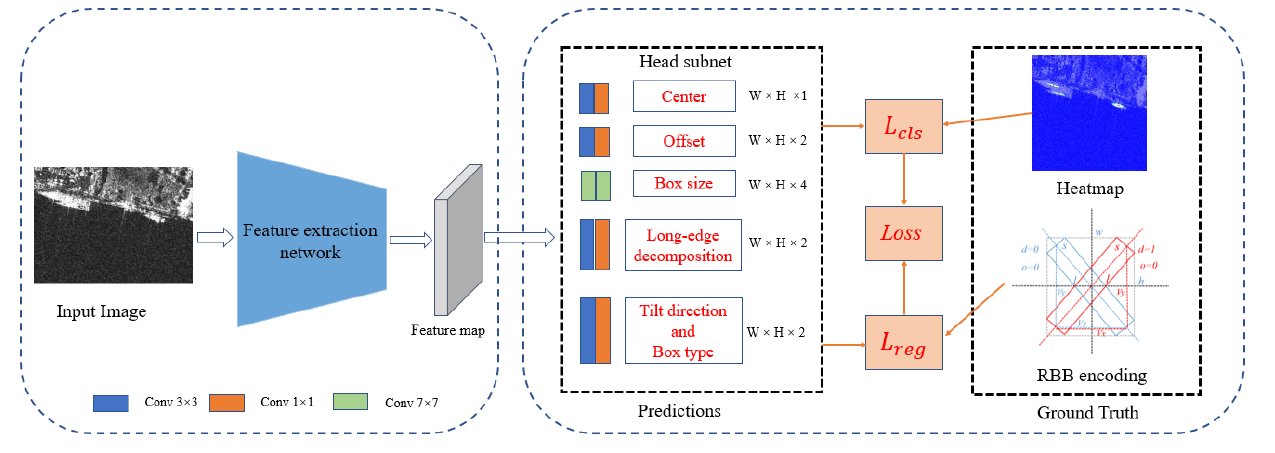
Figure 6. Model structure.